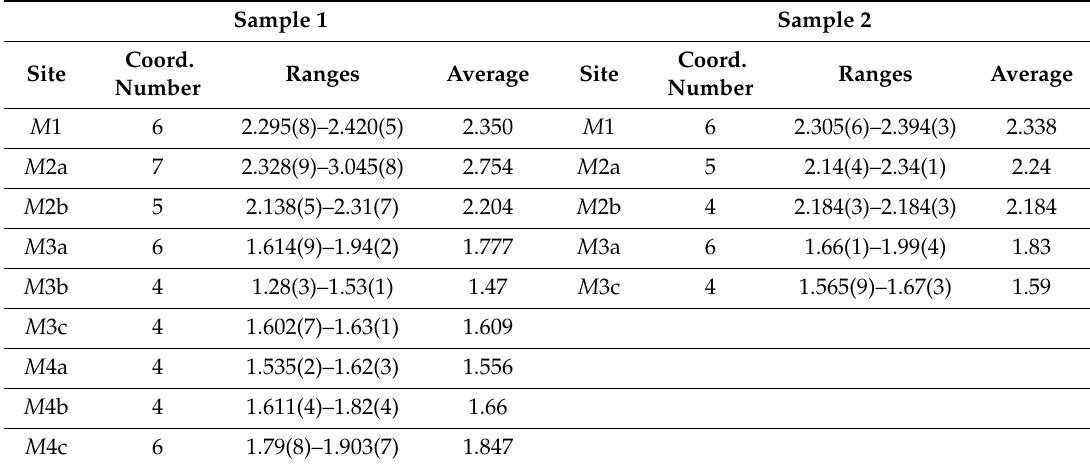
Table 3. Selected interatomic M –O distances (Å) in the structures of the Samples 1 and